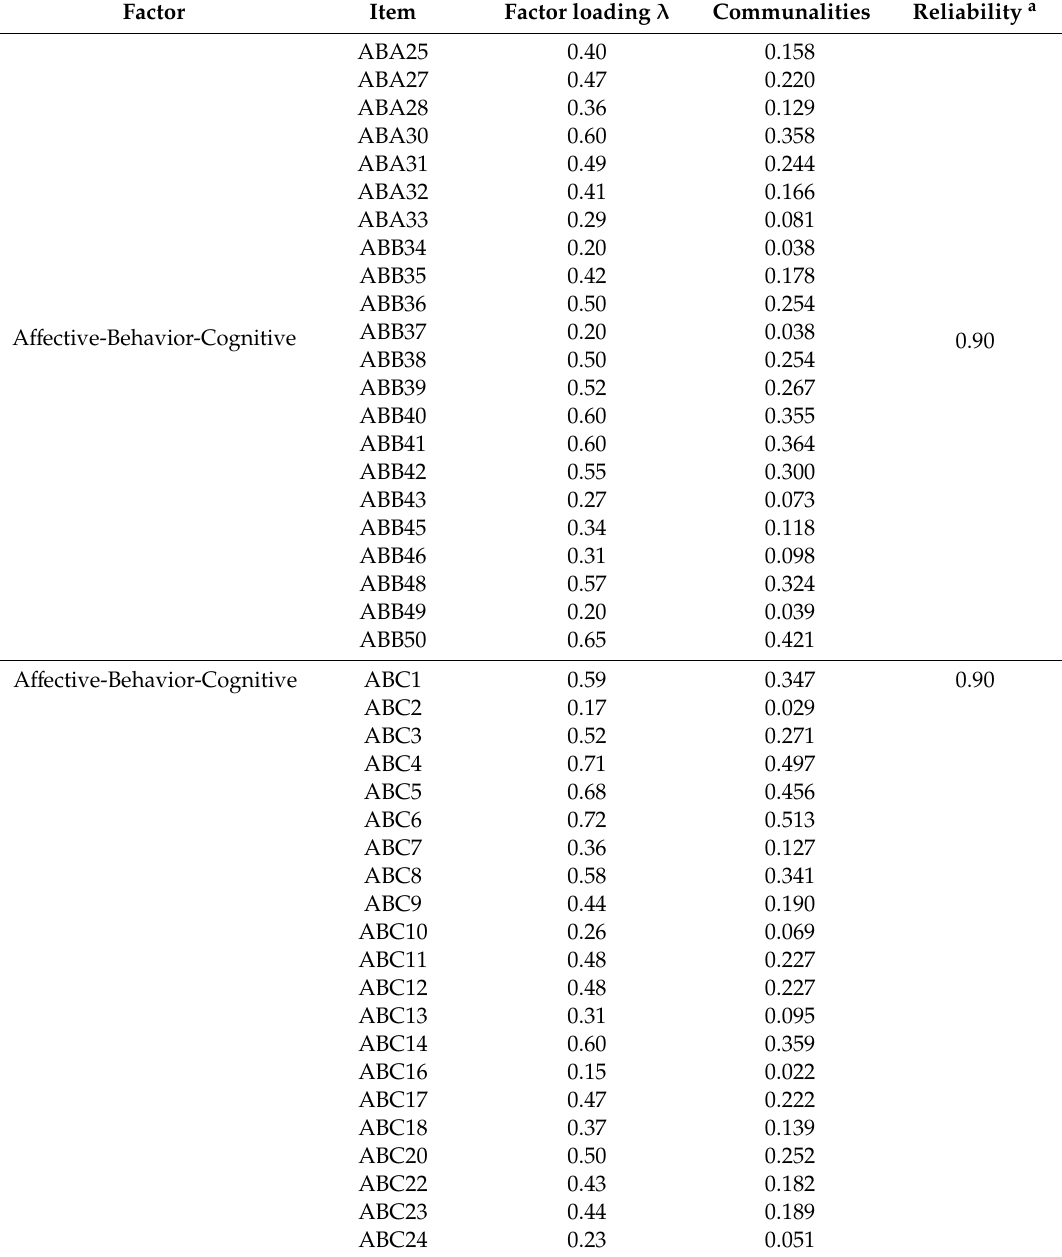
Table 6. Result of factor analysis and reliability analysis of attitude in complementary feeding section of IYCF-CCPQ. Factor Item Factor loading λ Communalities Reliability